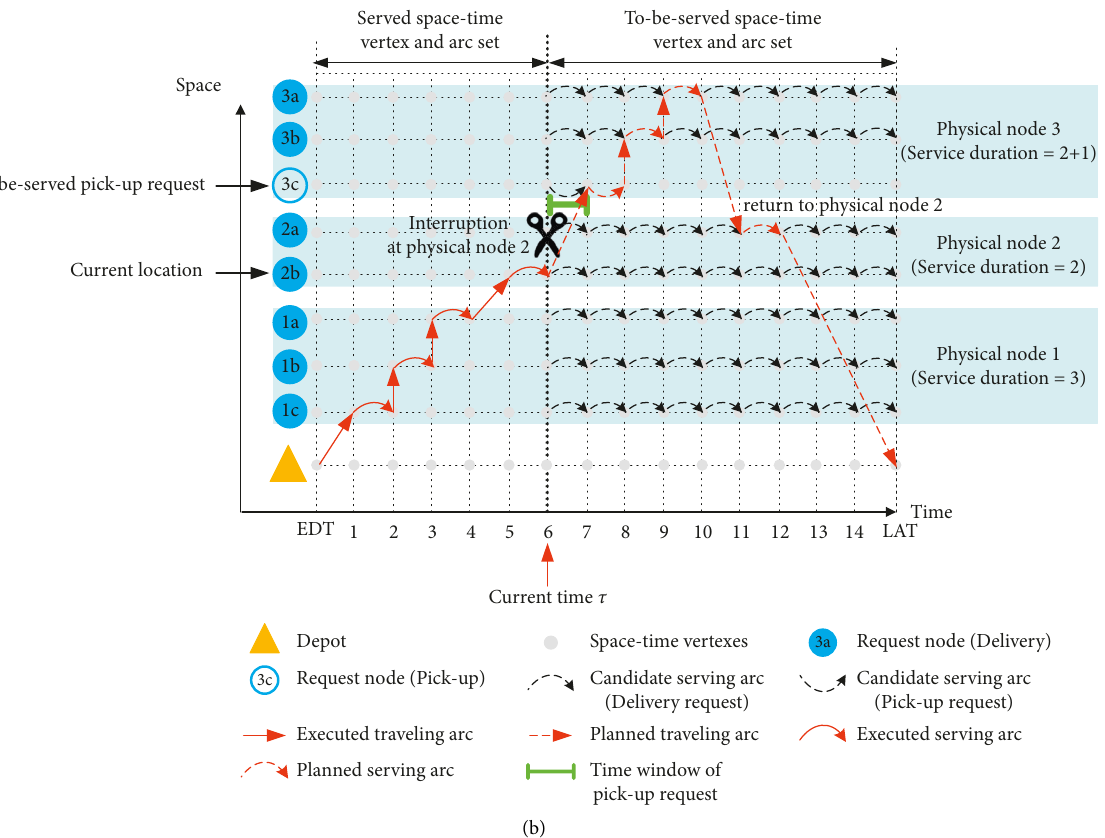
Figure 5: Space-time network in a 3-node example. (a) Space-time network for 3-node example (non-preemptive service) and (b) space- time network for 3-node example (preemptive